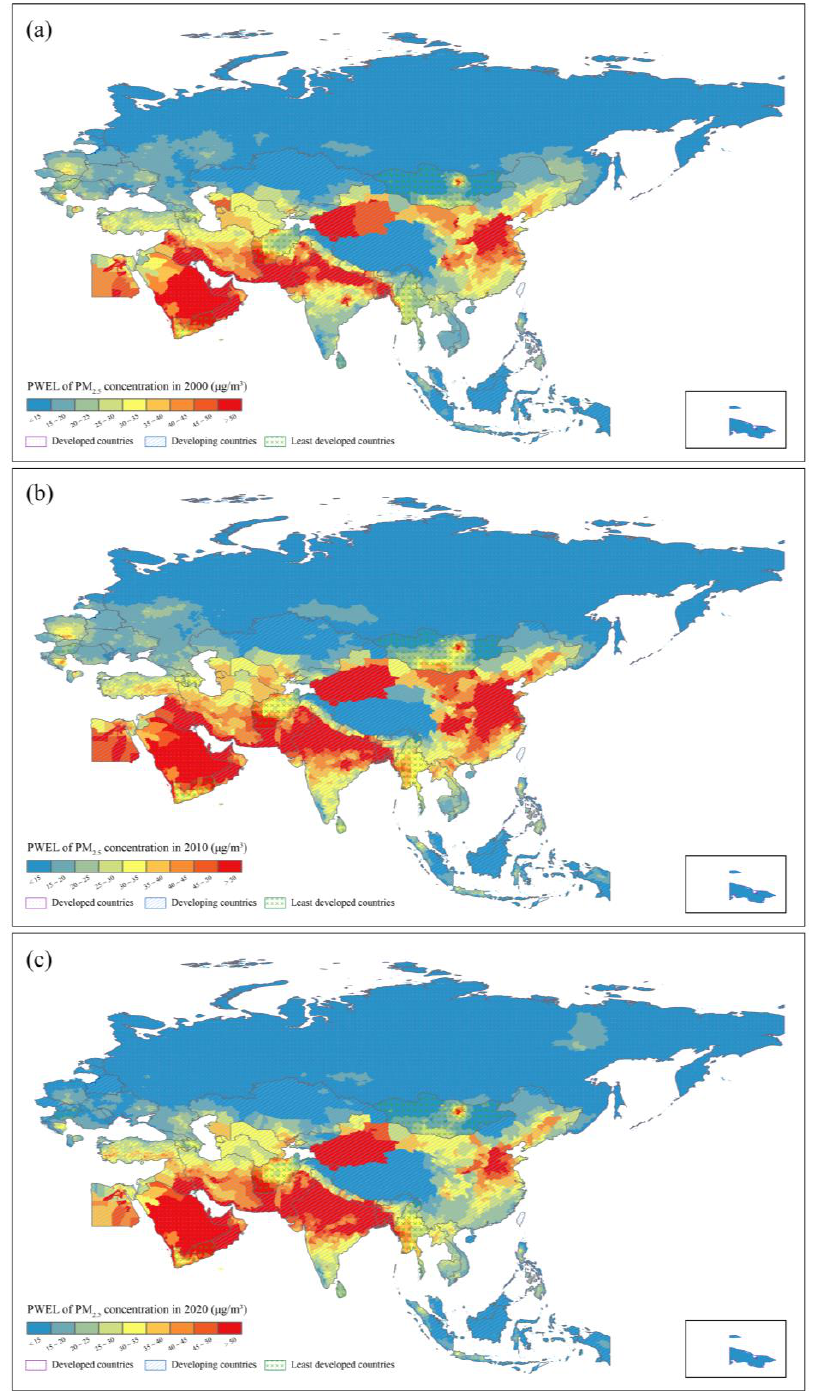
Figure 6. Spatial distributions of PWEL of PM 2.5 concentration in ( a ) 2000, ( b ) 2010, ( c ) 2020 in B&R region at city-level. region at